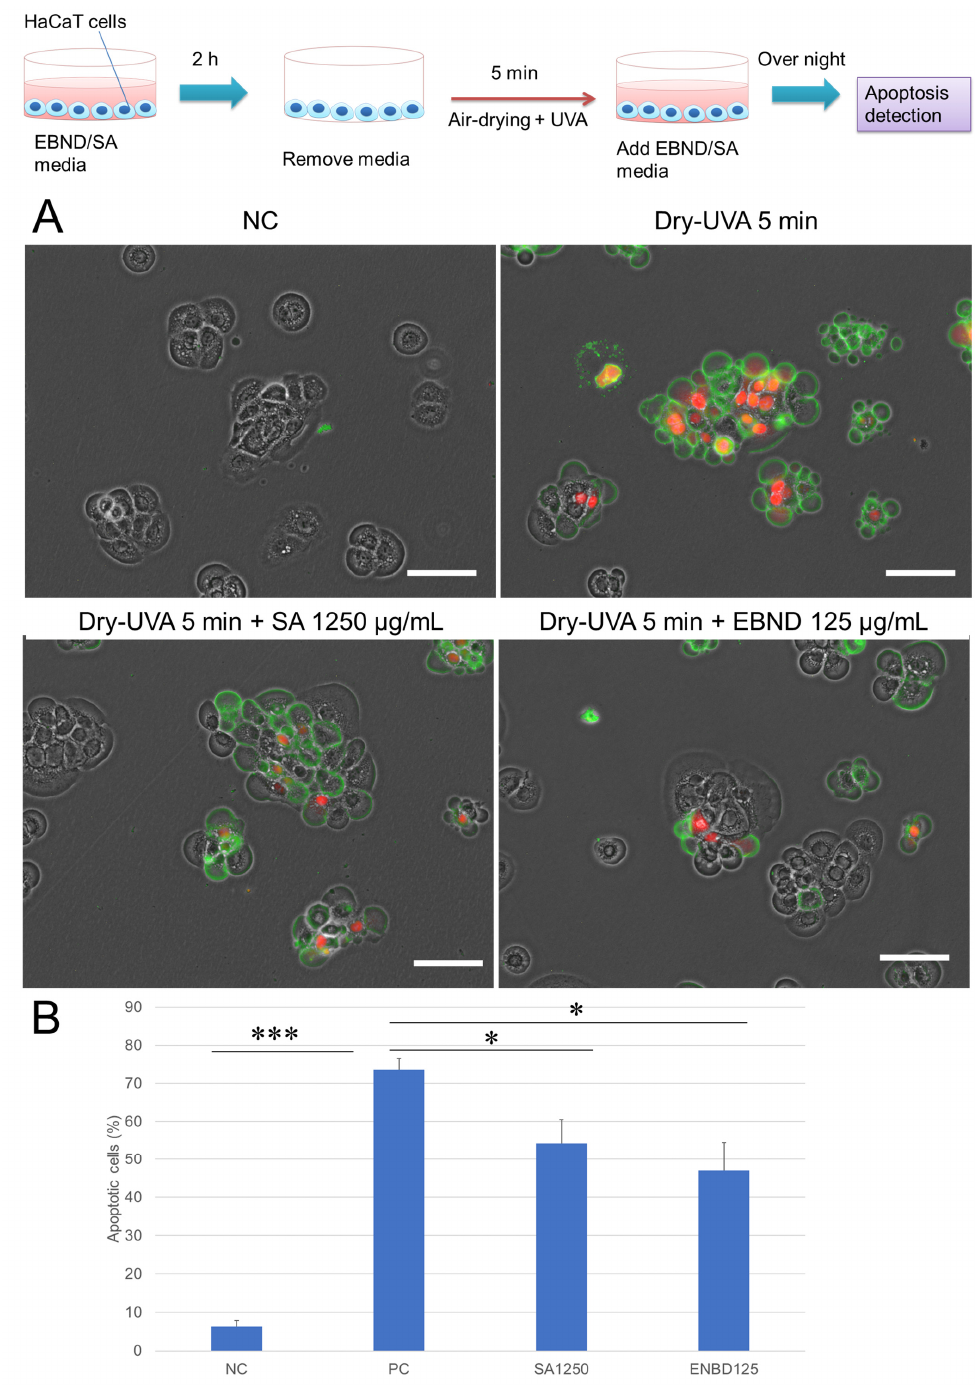
Figure 3. Effects of EBND and SA on Dry-UVA-induced apoptosis in HaCaT cells. The top illustration represents the procedures for the experiments. HaCaT cells were treated in the same manner as in the description in Figure 2. At the end of the experiments, apoptotic cells were detected by Annexin V/PI staining. ( A ) Typical images of Annexin V/PI staining. Green, Annexin V. Red, PI. Scale bar = 50 µ m; ( B ) Results of apoptotic cells (analyzed by Tali imaging cytometer). * p < 0.05, *** p < 0.001 vs. PC. Each bar represents the mean ± SD of the three independent experiments. These data suggested that EBND could protect HaCaT keratinocytes from Dry-UVA- induced cellular membrane damage and cell